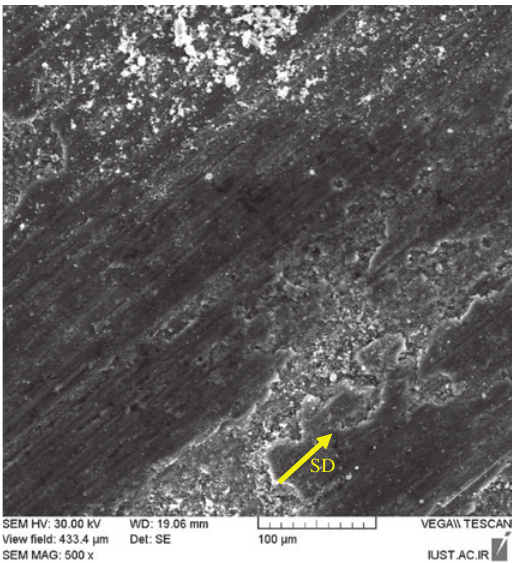
composite at peak Figure 17: Wear surface of AA8090/6% SiC p aged under rapid heating process at 30 N load.